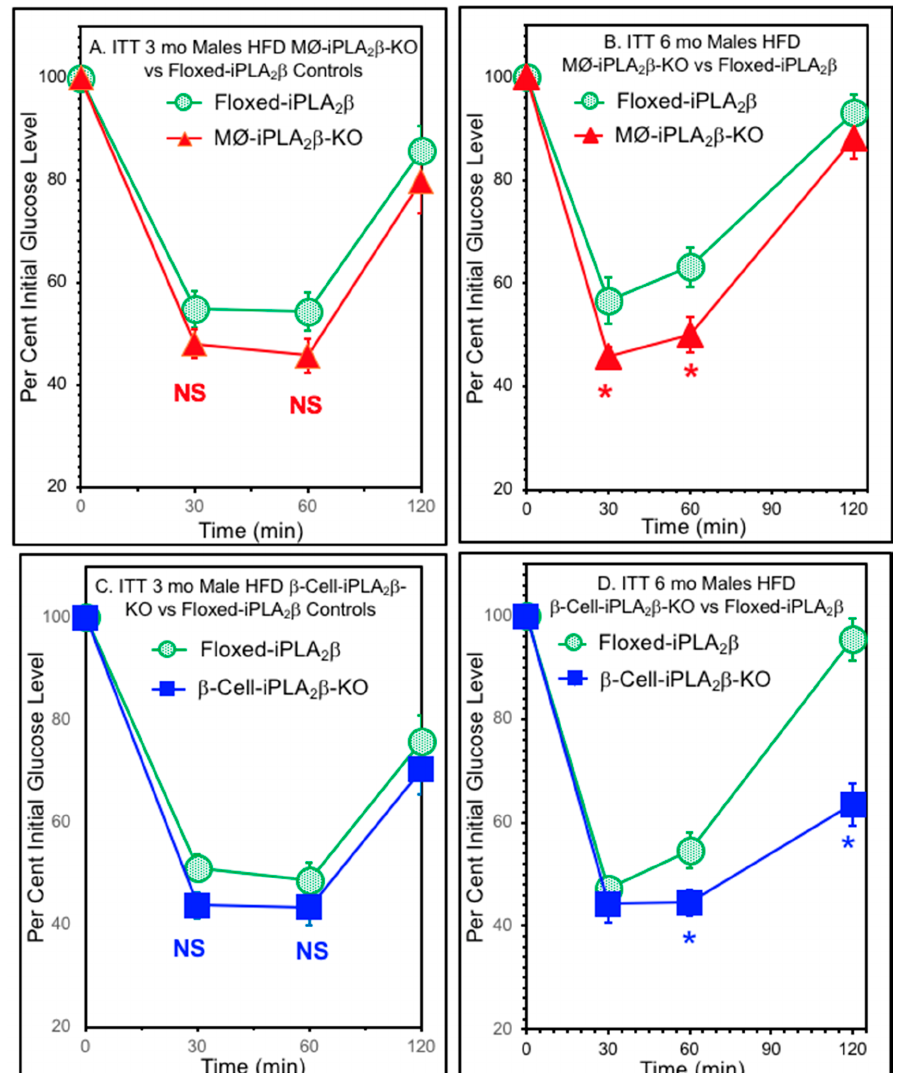
Figure 6. Insulin tolerance tests of 3- or 6-month-old male conditional iPLA 2 β -knockout mice and floxed-iPLA 2 β controls fed a regular or high-fat diet. Male floxed-iPLA 2 β control mice (circles), MØ-iPLA 2 β -KO mice (triangles), or β -cell-iPLA 2 β -KO mice (squares) mice were fed a regular diet after